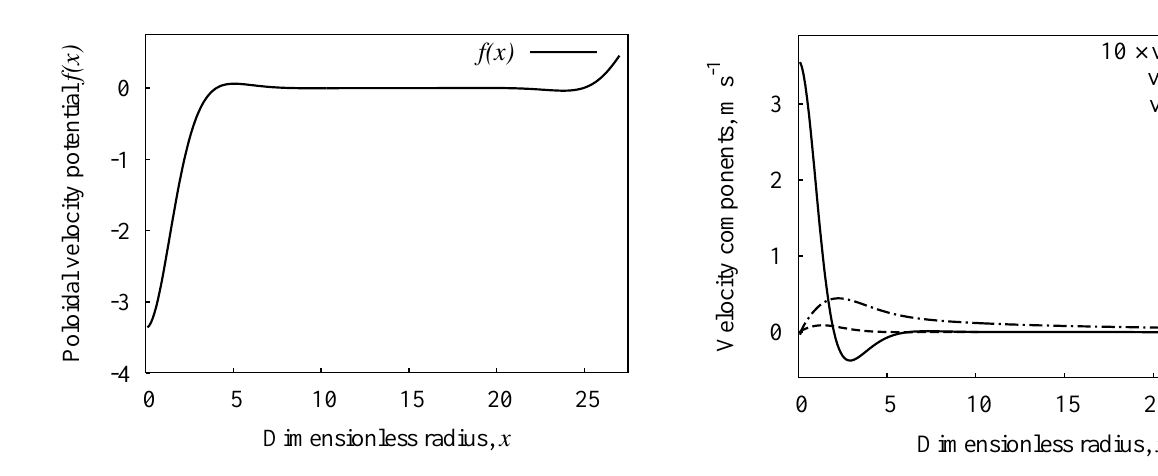
Figure 2. The best approximation of dimensionless poloidal ve- locity profile f ( x ). The values of the parameters A and a 2 in the Taylor expansion (Eq. 20) correspond to the position of the peak in Fig. 1.